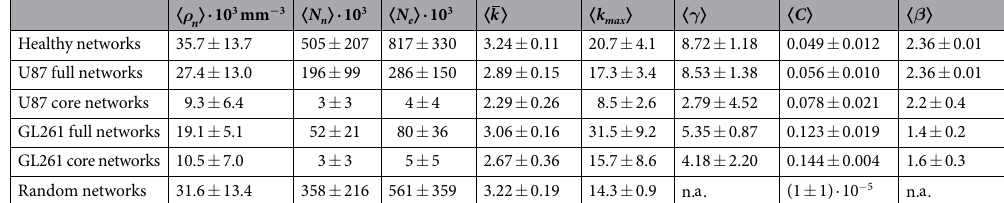
Table 2. Mean basic network properties with SD among, n = 6 healthy and tumor-bearing specimens, respectively. , as well as the total number of branching nodes N n and edges Node density in (shrunken) tissue volume ρ n N e per specimen. Mean local connectivity measures from all healthy and tumor specimens, including mean node degree k , maximum degree per specimen k max , and clustering coefficient C ; the scaling exponent β from fitting ∼ β − C k k ( ) is given with SD among samples. For comparison, corresponding quantities are also given i i i for n r = 12 Erdös-Rényi graphs 66 with node and edge numbers equal to the healthy and full U87 networks. n.a.: not